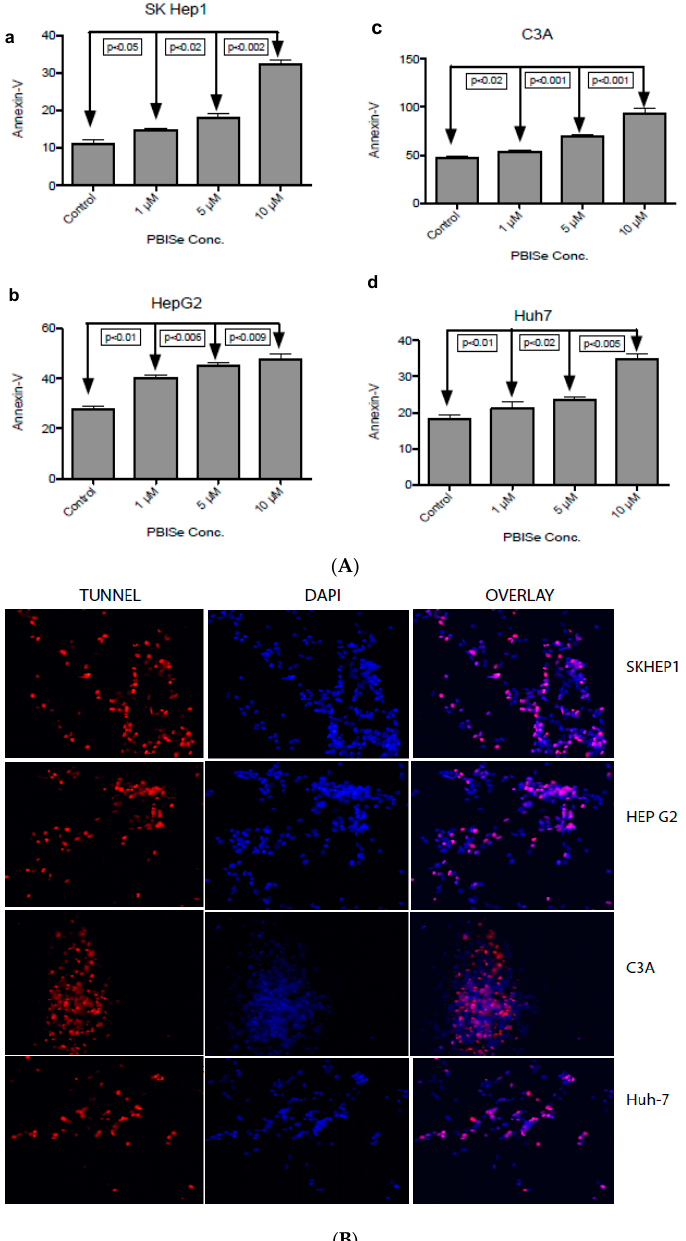
Figure 3. PBISe induces late stage apoptosis resulting in DNA fragmentation. Four different cell lines were used to demonstrate the late apoptotic process. ( a ) Skhep1; ( b ) HepG2; ( c ) C3A; ( d ) Huh-7. The cells were grown in 100 mm petridishes in 10% MEM, and then treated with different concentration of the drug for 48 h. Approximately 1 × 10 6 treated cells were suspended in 1X binding buffer. One-hundred microliters of suspended cells containing 1 × 10 5 cells were stained with 5 μ L of FITC labeled annexin-V and 5 μ L of Propidium iodide (PI) for 15 min at RT in dark. Apoptosis is measured by flow cytometry within one hour of staining. Graph showing the total apoptotic cell death from three quadrants representing the PI stained cells (early apoptotic), annexin-V staining (Late apoptotic) and double positive (early and late apoptotic). The p values are determined for all the indicated concentrations compared to control ( A ). As an indication of late stage apoptosis, PBISe induced DNA fragmentation of Skhep1, HepG2, C3A and Huh7 cell lines was performed by Tunnel assay. The cells are grown on the coverslip in a 6 well plate, treated with 10 µ M conc. of PBISe for 48 h. The treated coverslips were fixed with paraformaldehyde followed by precooled ethanol and acetic acid. The coverslips were labeled with Apo tag red for Tunnel (red) and counterstained with DAPI nuclear stain (blue). The pictures were taken with Leica confocal microscopy ( B